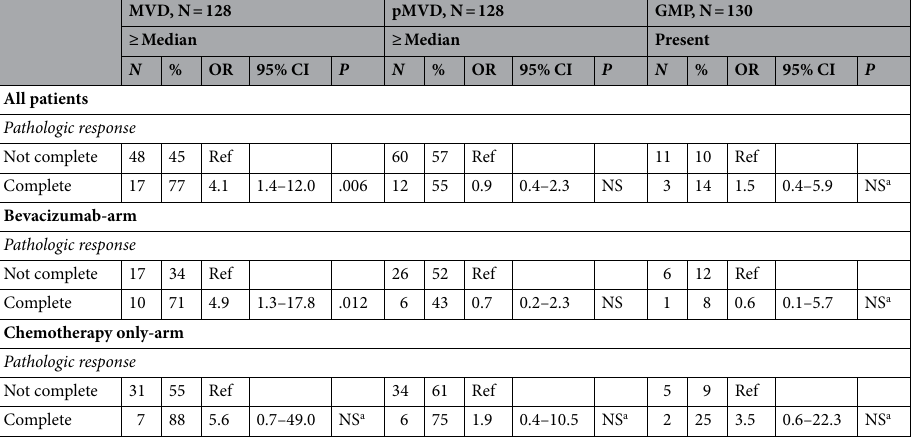
Table 1. MVD, pMVD, GMP according to pathologic complete response (pCR). All patients: MVD and pMVD analyses: Pathologic complete response: N = 22; bevacizumab-arm: N = 14, chemotherapy only- arm, N = 8. GMP analyses: Pathologic complete response: N = 21; bevacizumab-arm: N = 13, chemotherapy only-arm, N = 8. MVD and pMVD; N = 128 (64 in each arm), GMP: N = 130 (bevacizumab-arm, N = 64, chemotherapy only-arm, N = 66). MVD microvessel density, pMVD proliferative microvessel density, GMP glomeruloid microvascular proliferation, N number of patients, OR odds ratio, CI confidence interval, P p values by Pearson’s chi-square test. a Fisher’s exact test.